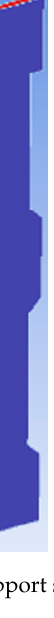
Table 2. Base input